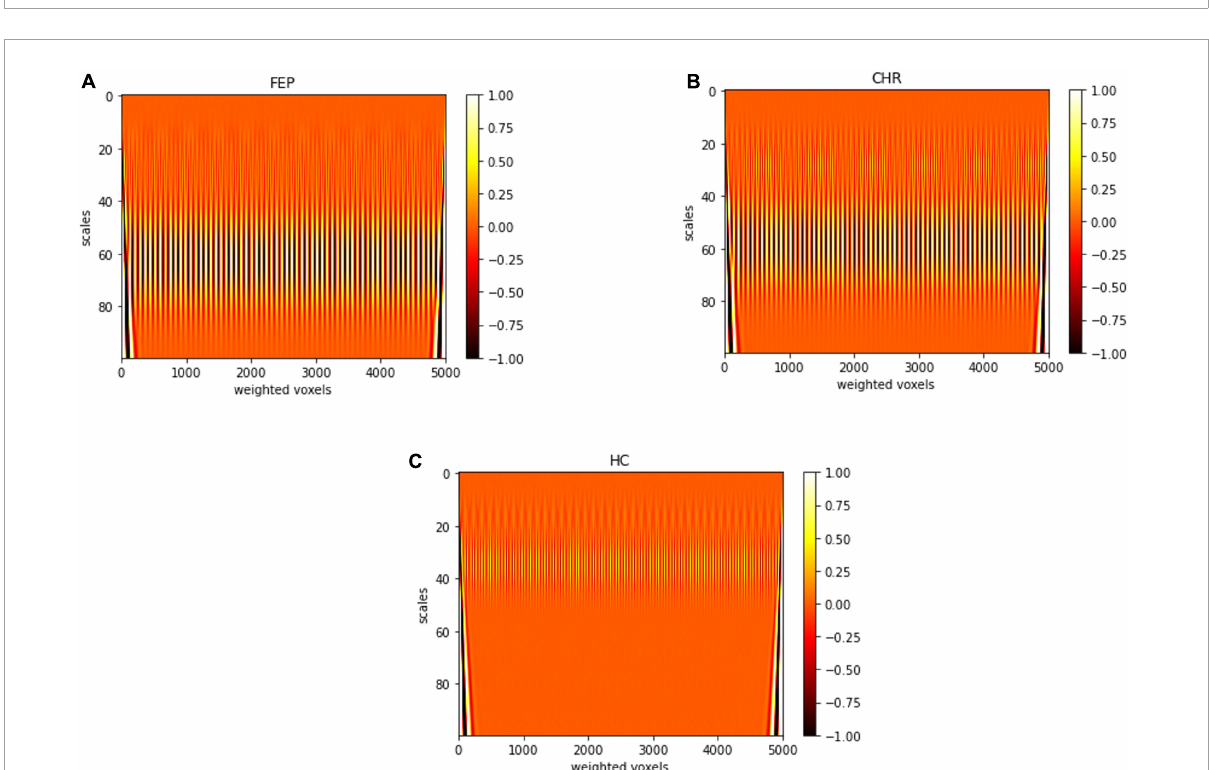
FIGURE6 Scalogram of one (A) FEP, (B) CHR, and (C) HC subject for 100 scales. Sampled voxels are represented in x -axis and scales in y -axis, the colors represent the correlation with the Morlet wavelet deep red color corresponds to lower and white color to higher correlation.